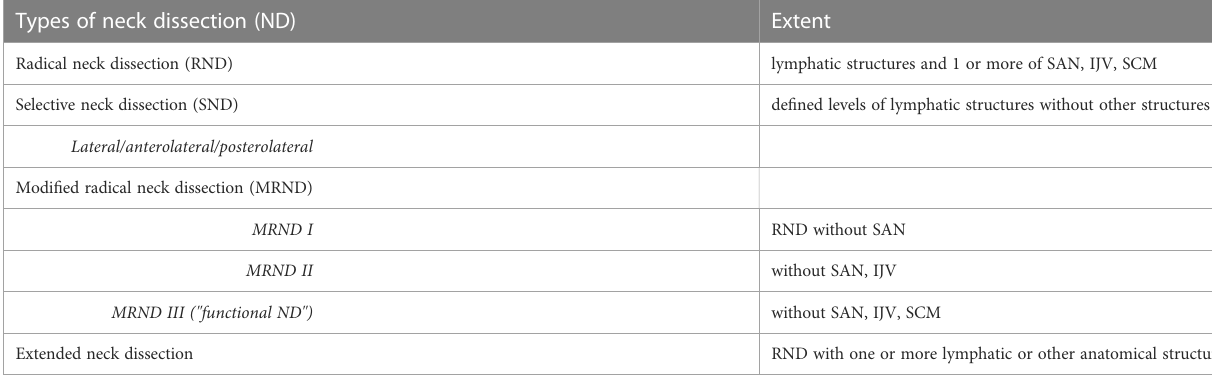
TABLE 2 Types of ND according to Robbins and